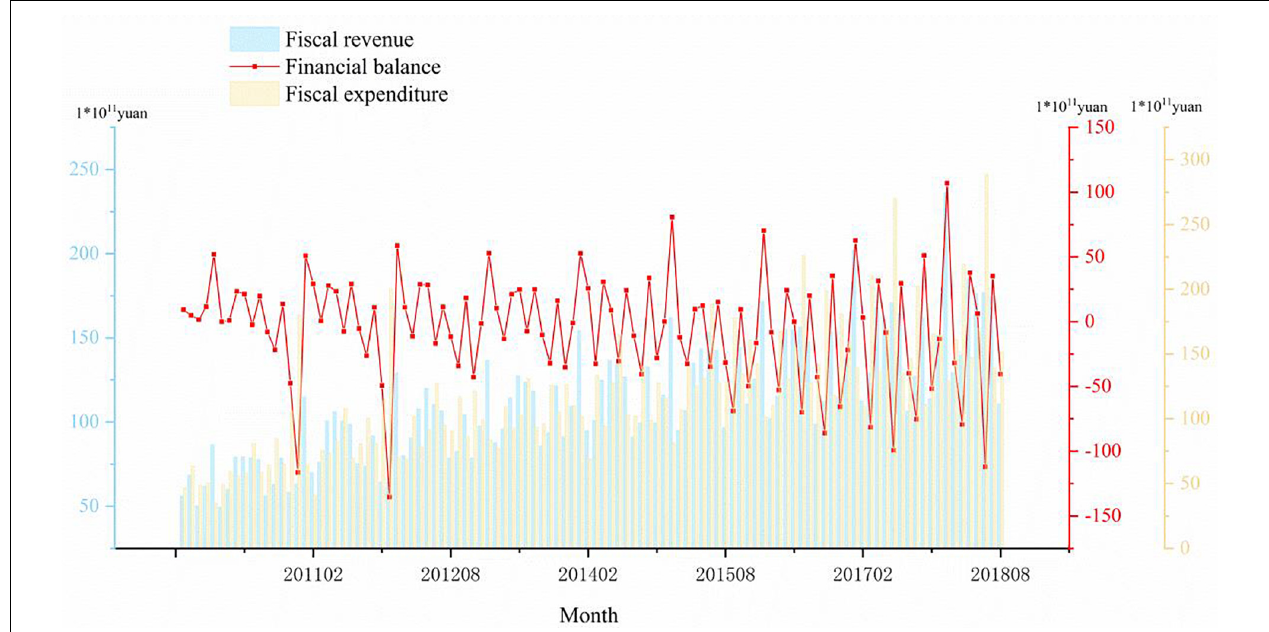
FIGURE 3 | Financial